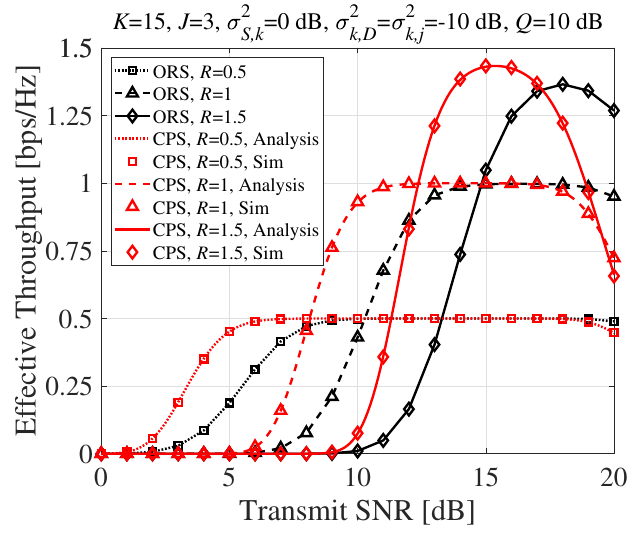
Figure 6. Effective throughput (bps/Hz) according to the transmit SNR